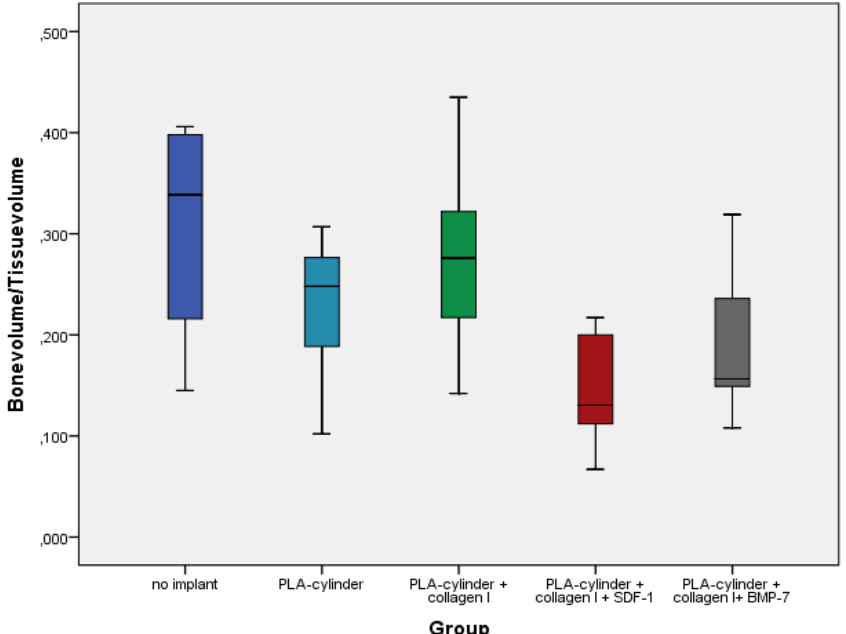
Figure 4. Quantitative analyses of bone volume / tissue volume ratios in the di ff erent groups 8 weeks after surgery.